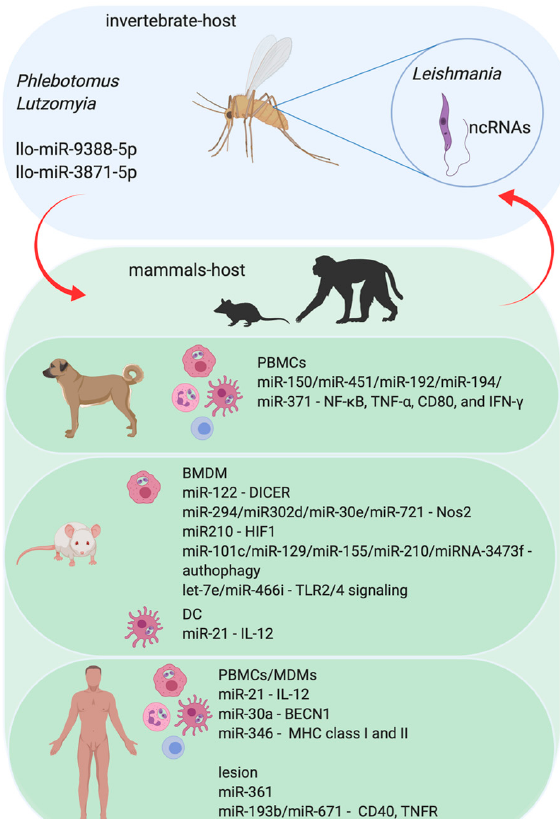
Figure 2. The role of miRNA in the Leishmania parasite and parasite–host interaction. The protozoan infection caused by Leishmania parasite leads to Leishmaniasis in mammalian hosts. The infection begins with the transmission during the blood meal of infected female sandflies ( Phlebotomus and/or Lutzomyia) and the consequent injection of infective promastigotes into the host’s epidermis. Flagellated and mobile extracellular promastigote form of Leishmania proliferate in the gut of sandflies. Upon penetration, promastigotes are identified by immune phagocytic cells, such as macrophages, neutrophils, and dendritic cells (DC). Once the parasites are phagocytized by these immune cells, they are di ff erentiated into amastigote forms and begin to multiply within those cells. Amastigotes have a reduced flagellum and ovaleted morphology and survive inside the phagolysosomal compartment. Parasites in promastigote form express noncoding RNAs (ncRNAs) that can regulate the invertebrate host–sandfly–metabolic pathways. However, sandflies also express miRNAs, which can a ff ect the parasite biology, influencing its success in the colonization of sandflies’ digestive tract and di ff erentiation to the infective forms and the vertebrate host. Not only do the invertebrate hosts express miRNAs, but the vertebrate one also does. The experimental models using human Monocytes Derived-Macrophages (MDM) or murine Bone Marrow-Derived Macrophages (BMDM), and also in the Peripheral Blood Cells (PBMCs) from human and dogs show that infection of mammalian hosts can interfere with the profile of host miRNAs. Also, the plasma samples or the cutaneous lesion site from leishmaniasis patients show modifications in the miRNA profile.